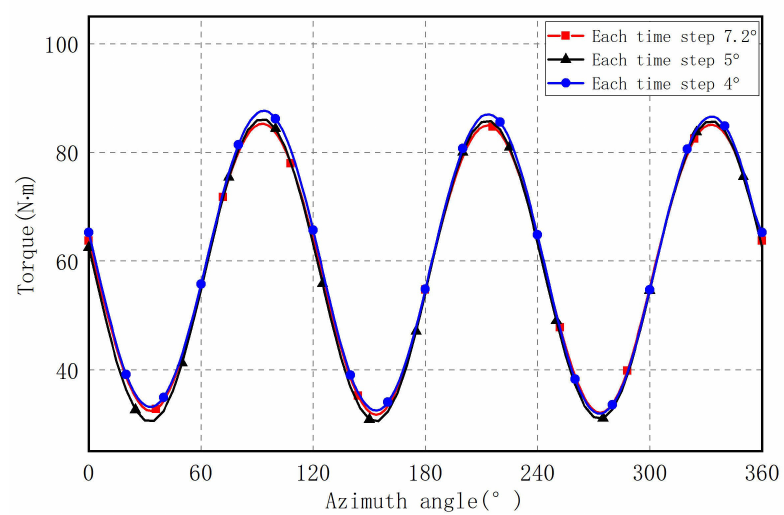
Figure 14. Curve of offshore wind turbine torque changing with azimuth (TSR =